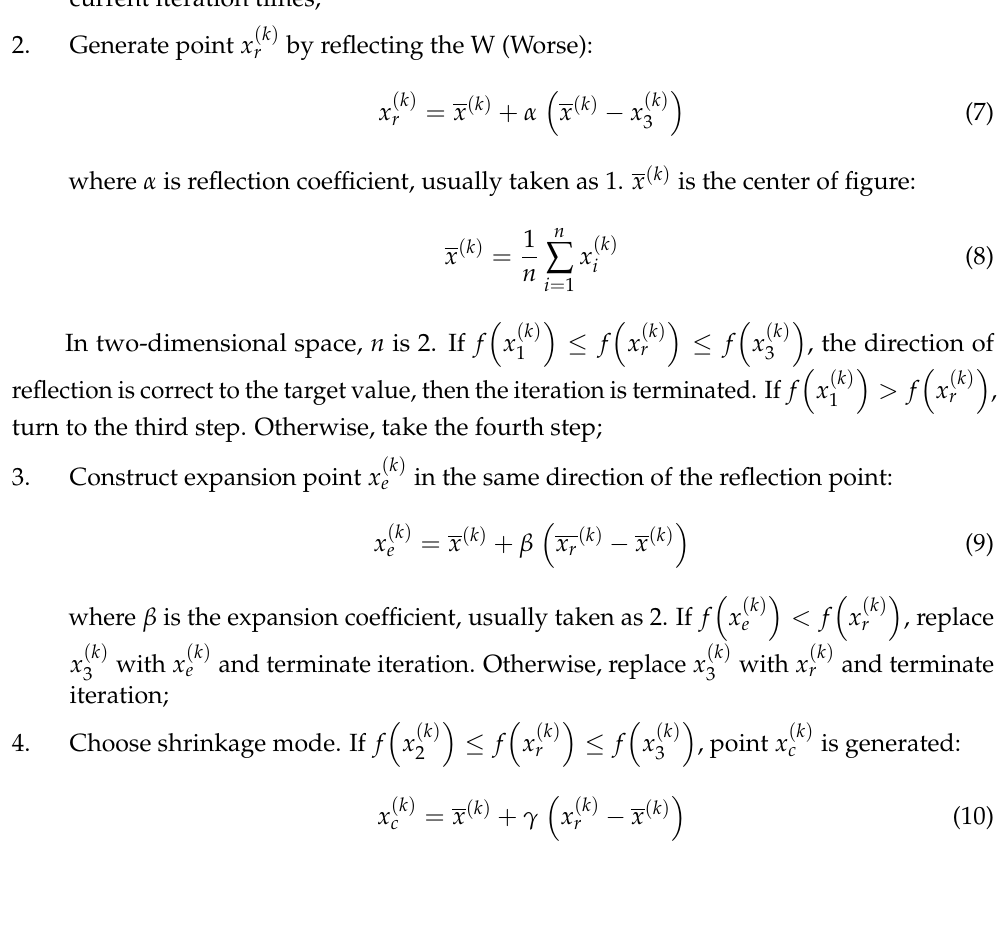
Table 3. Main structure parameters of the buffer after optimization.